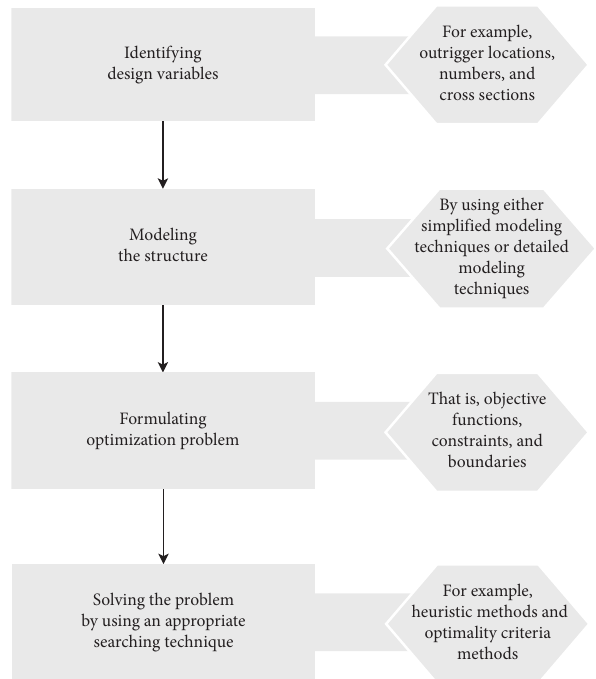
Figure 2: Procedures of optimum topology and size design for outrigger and belt-truss